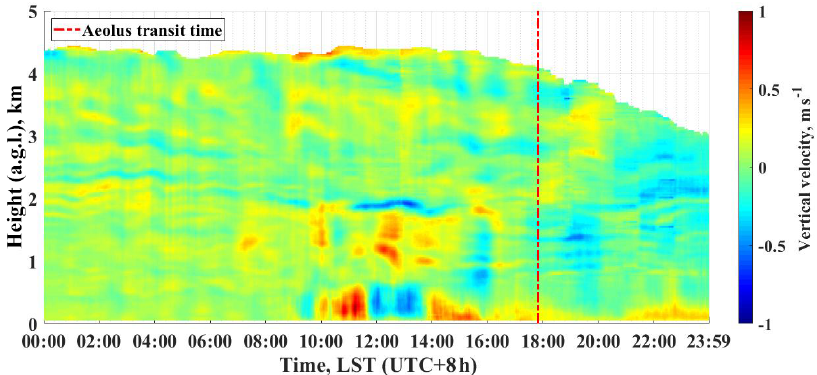
Figure 6. Vertical velocity (moving average of 30min) measured on 16 November 2020 in Qingdao (Shandong Province), China. The dashed red line indicates the Aeolus transit time.